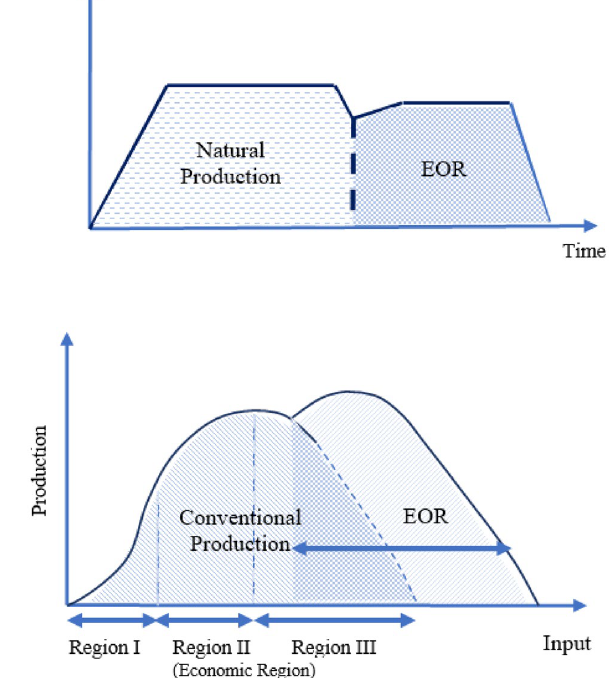
Fig. 9 Oil production rate from